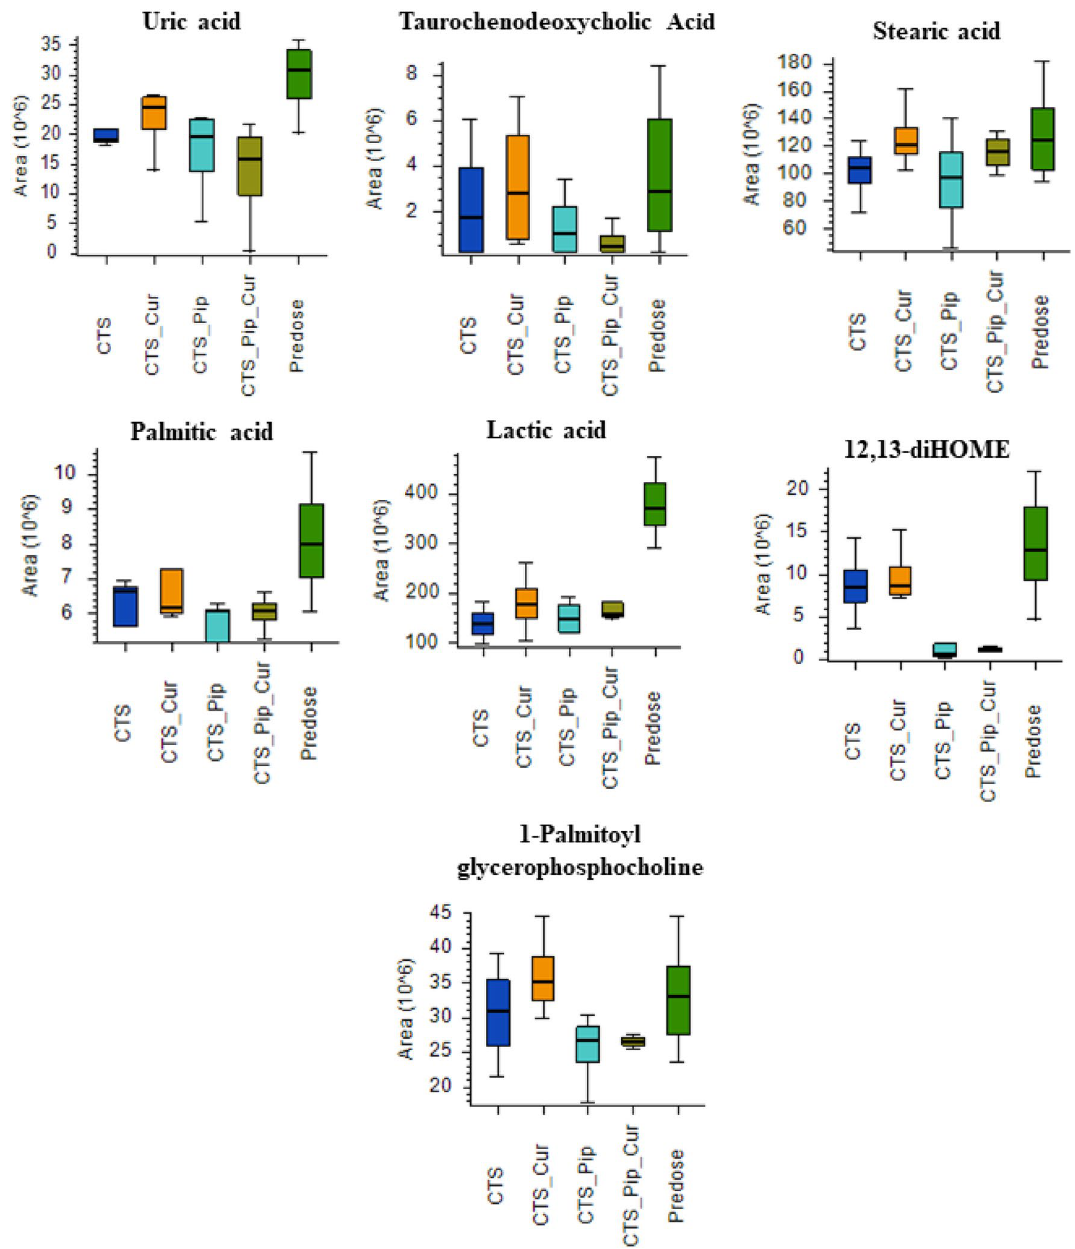
Figure 5. Boxplots of the metabolite biomarkers that changed 4 h after administration of Centella asiatica (CTS) extract alone, in combination with curcumin (CTS_Cur), in combination with piperine (CTS_Pip) and in combination with both curcumin and piperine (CTS_Pip_Cur) in the negative mode of